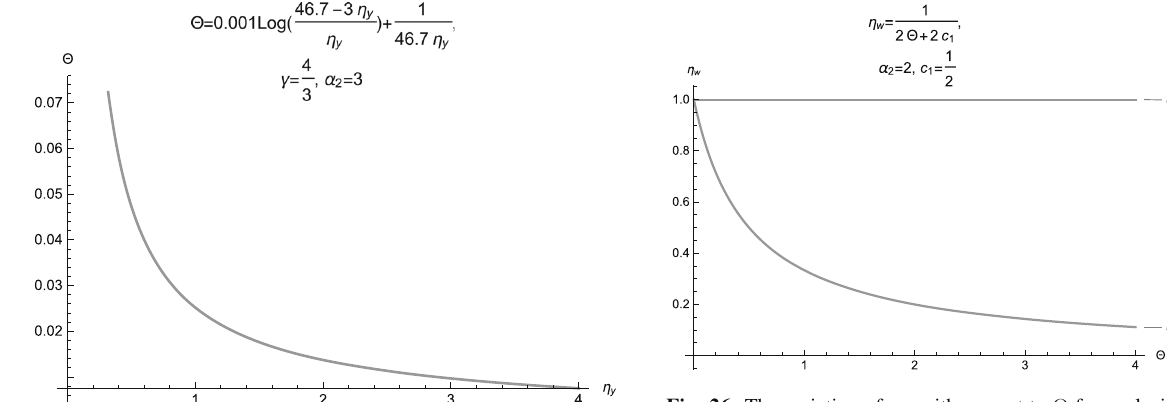
Fig. 26 The variation of η w with respect to (cid:16) for analysing stability at infinity for case III